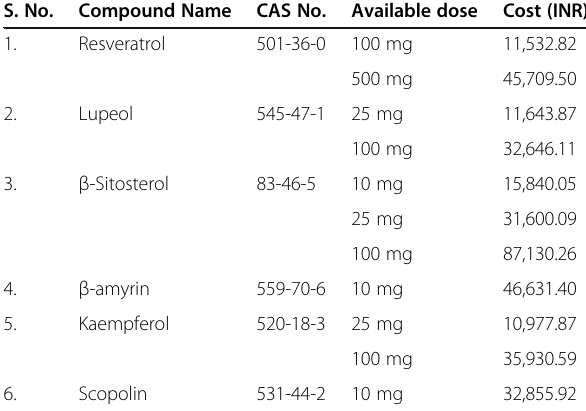
Table 3 Similar molecules and their prices in the market S.